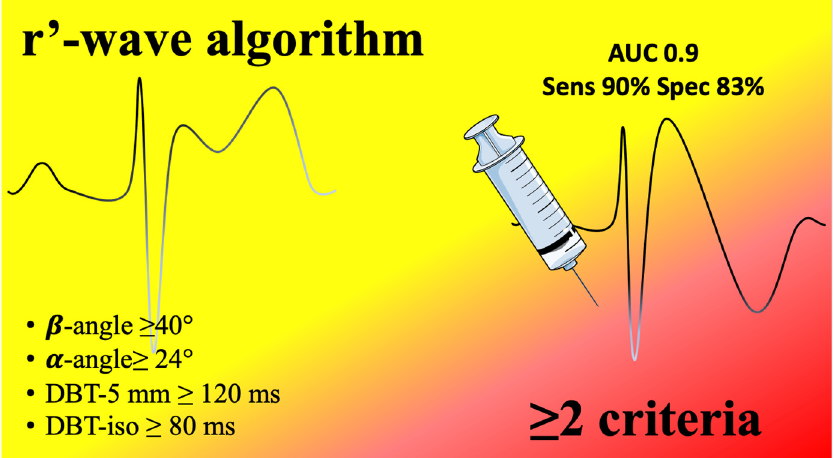
Figure 3. r’-wave algorithm illustration.